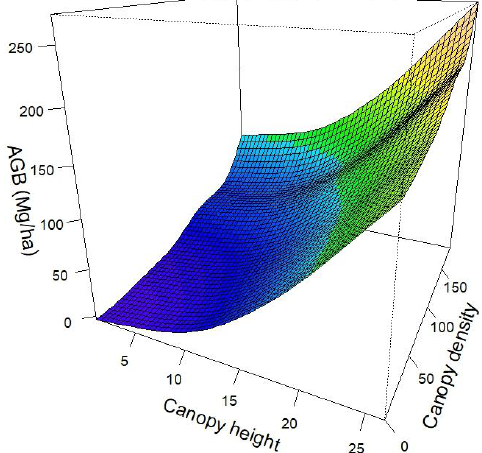
Figure 4. Effect for each factor on AGB by the generalized additive model (GAM). Canopy height (the 95th percentile height for all returns above 2 m), and canopy density (All returns above 3 m × 100/first returns) are metrics derived from LiDAR.